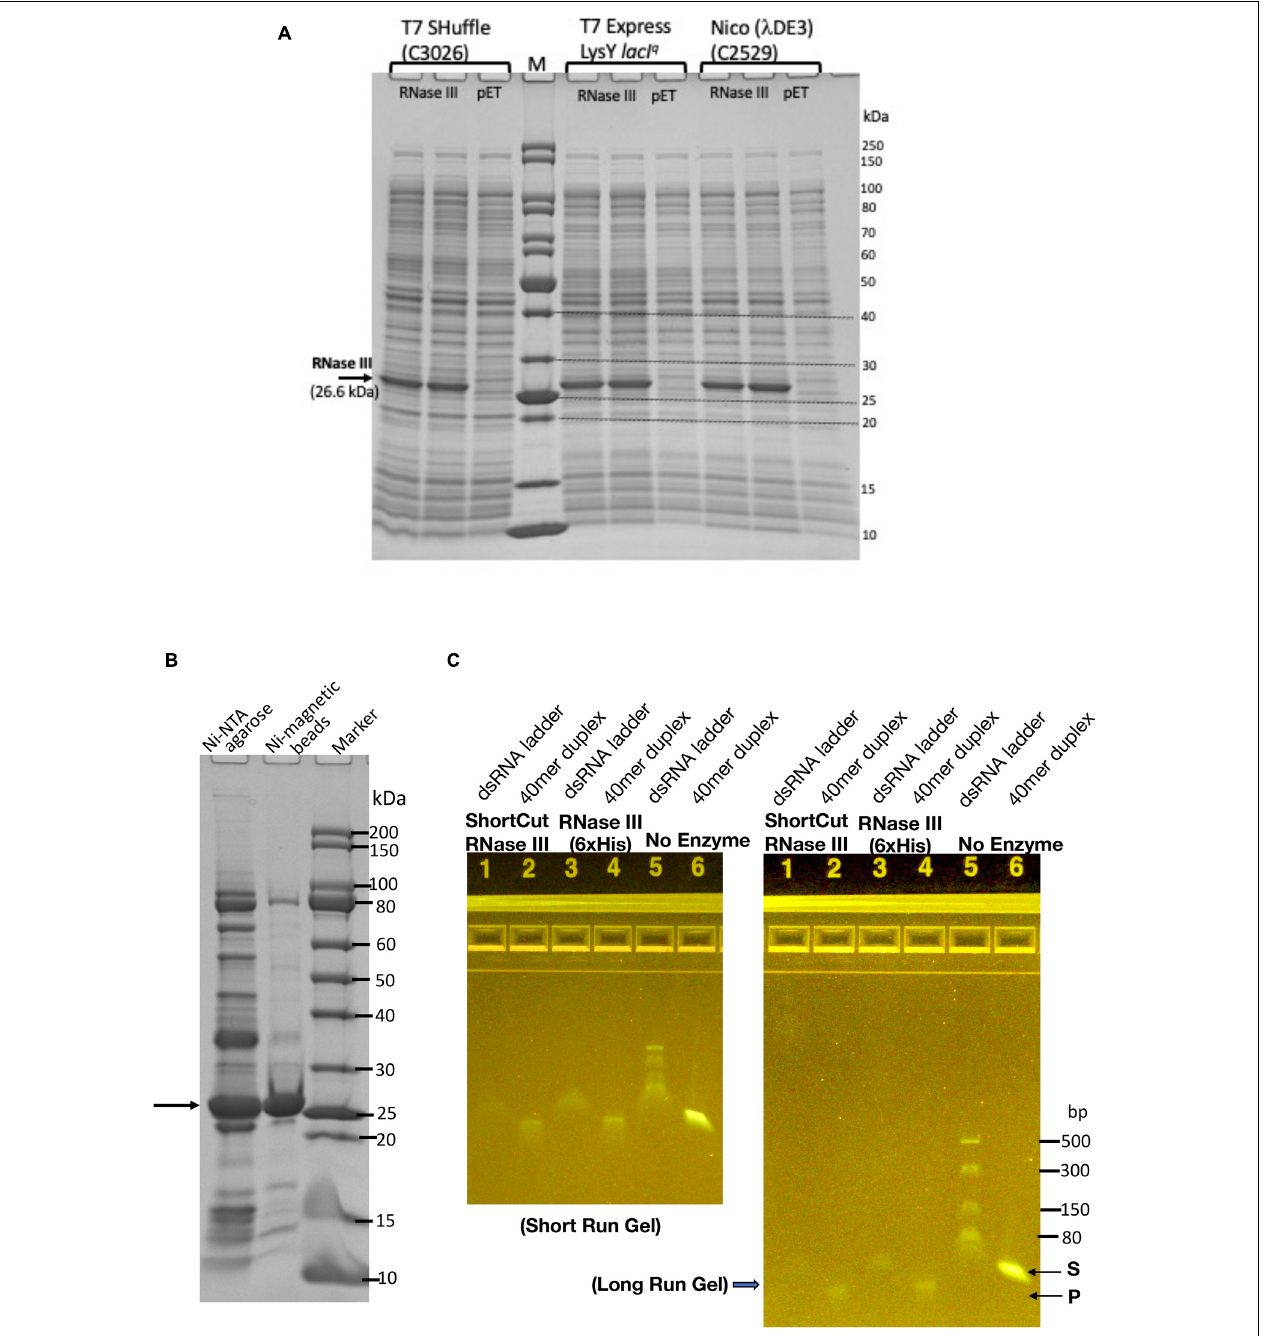
FIGURE 4 | Expression and purification of E. coli RNase III and RNase activity assay on dsRNA. (A) RNase III expression level in three E. coli T7 strains: T7 Shuffle (C3026, K strain), T7 Express with lacI q and LysY (C3013), and Nico ( λ DE3). (B) Purified RNase III from nickel-NTA agarose column chromatography and Ni magnetic beads. (C) Ribonuclease activity assay on dsRNA (40 mer duplex and dsRNA ladder).